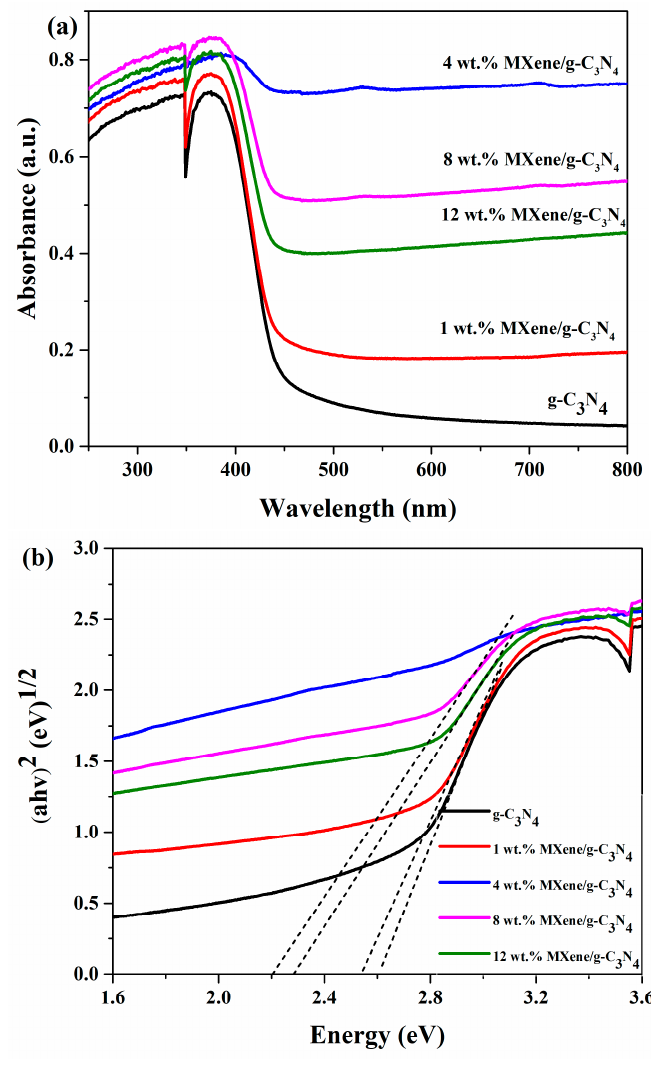
Figure 7. ( a ) UV-Vis diffuse reflection absorption spectra and ( b ) Tauc plots of the as-synthesized MXene/g-C 3 N 4 heterostructure photocatalysts.